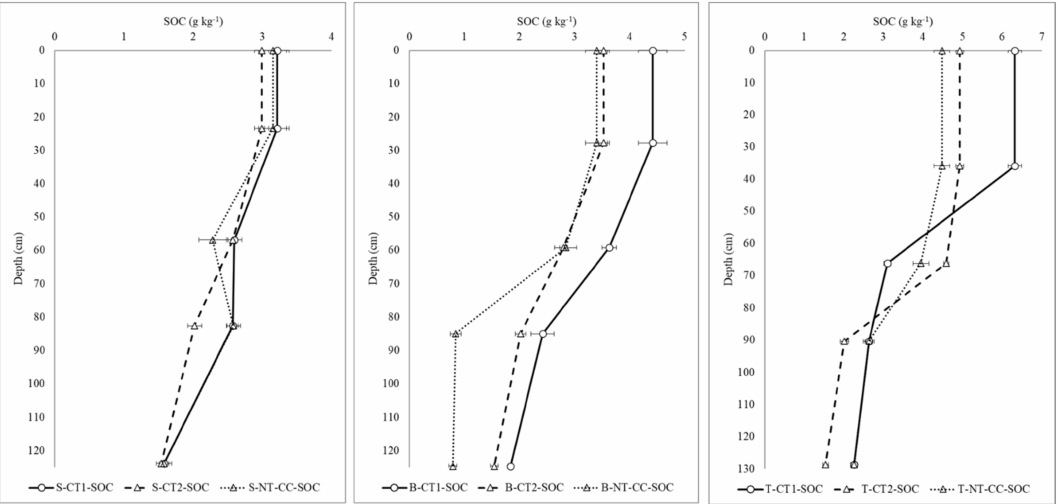
Figure 4. Soil organic carbon content in the hillside position. Conventional tillage and no tillage with cover crops. S: summit, B: backslope, T: toeslope; CT1: conventional tillage 2017, CT2: conventional tillage 2019, NT-CC: no tillage with cover